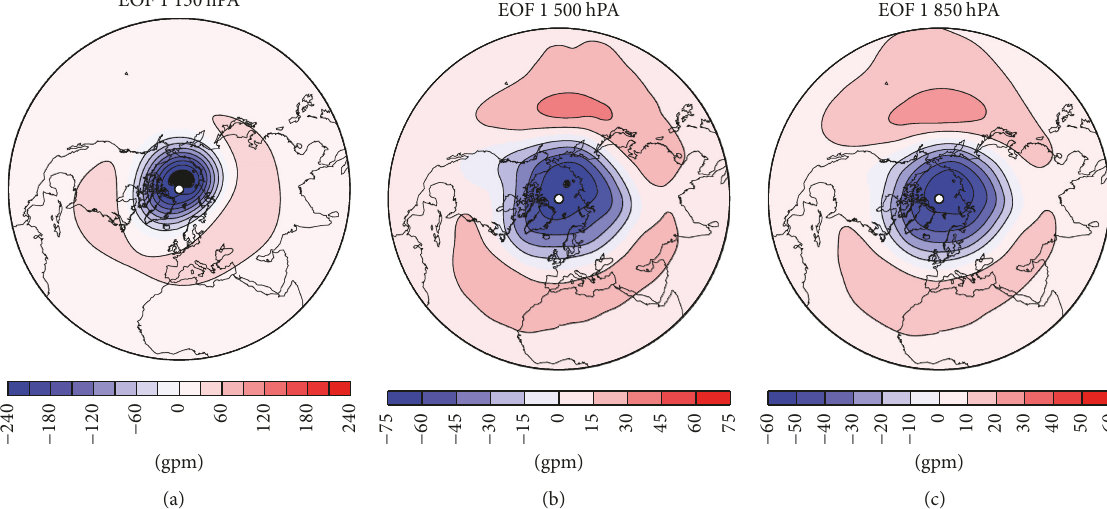
Figure 6: First EOF of geopotential height (gpm) at the three model levels: upper level (a), middle level (b), and lower level (c).